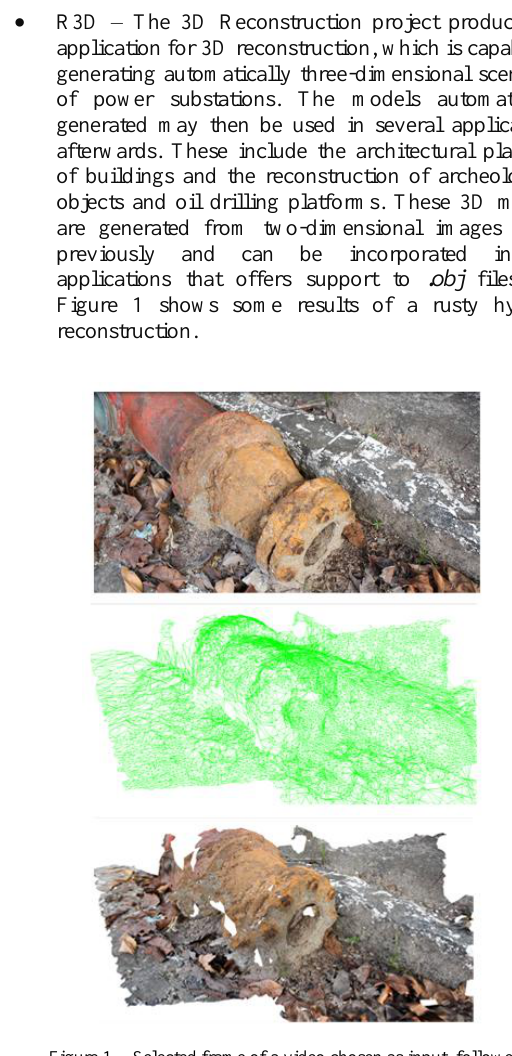
Figure 1. Selected frame of a video chosen as input, followed by its reconstruction: mesh and texture views